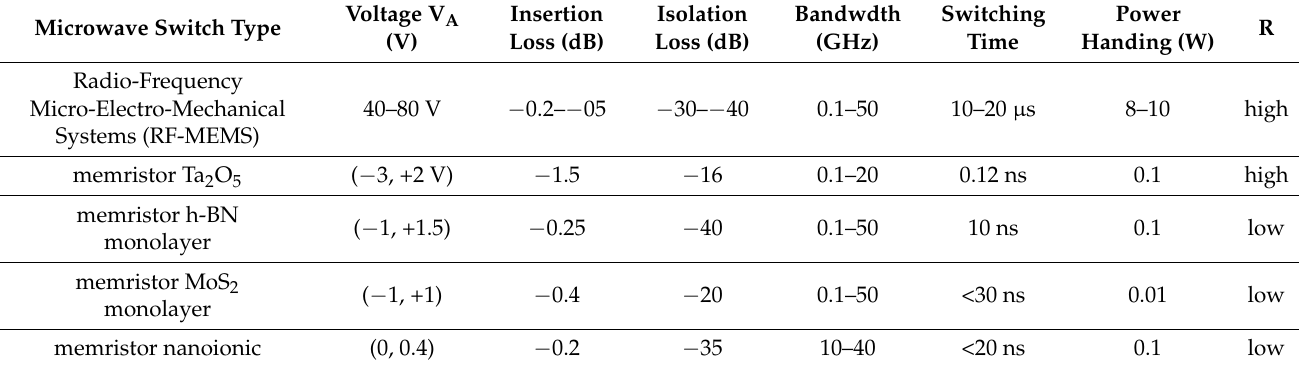
Table 1. The microwave performance of atomically thin memristors extracted from experimental data. Microwave Switch